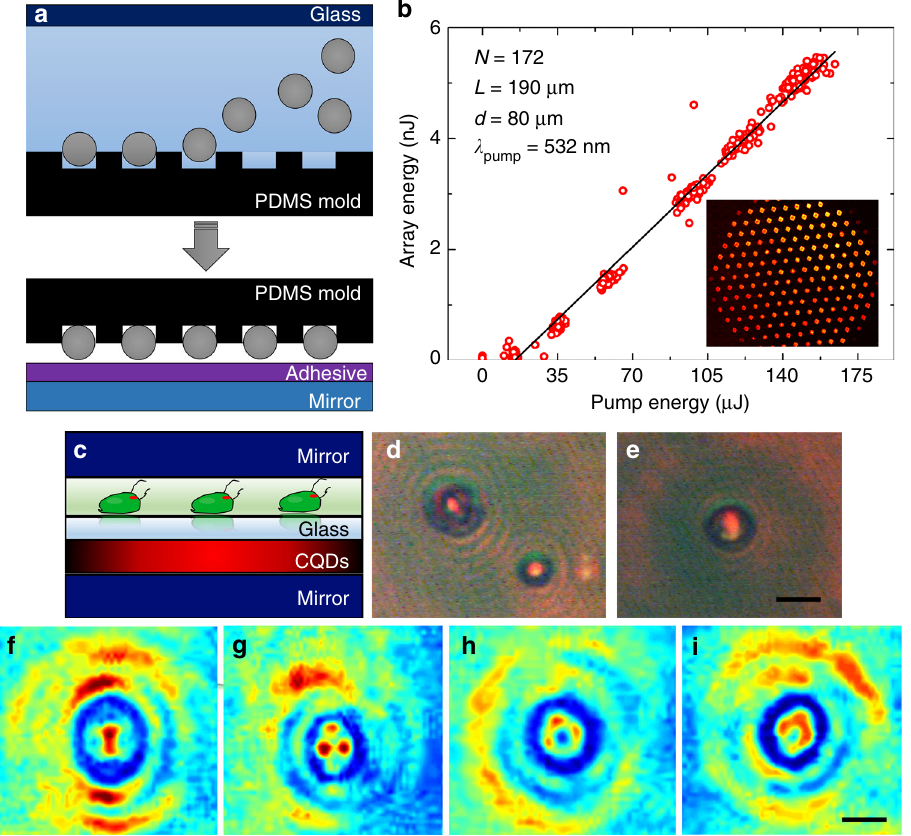
Fig. 5 Resonators designed for multiple-beam generation with close-packed microsphere arrays or for the analysis of single cells in vivo. a Diagrams illustrating two steps in the placement of microsphere arrays onto the surface of a mirror with a PDMS template. b Dependence of laser output pulse energy on the pump (532nm) pulse energy for an array of 172 microspheres. The inset is an optical micrograph of a portion of the hexagonal array while lasing, and the least-squares fi t to the data is represented by the black line. c Cross-sectional diagram of a double-chambered resonator incorporating living C. reinhardtii cells. d , e Photographs of C. reinhardtii cells showing lasing in the cytoplasm of the unicellular organism. f - i False color versions of optical micrographs of C. reinhardtii , illustrating several observed laser mode patterns. Note the spatial scale (10 μ m) in i and the interference fringes outside the